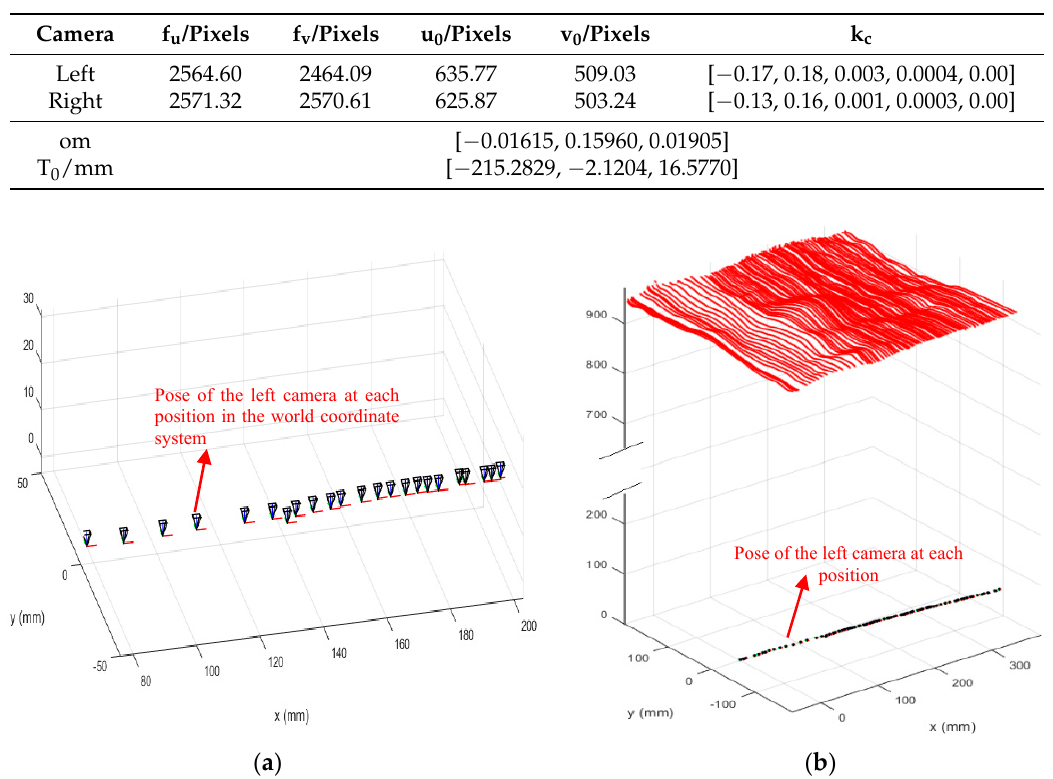
Figure 8. Splicing the light strips based on the camera pose information. Graph ( a ) shows the pose information of the left camera at the first 23 positions, and graph ( b ) shows positions of the restored light stripes and pose of the left camera in the world coordinate system. Sensors 2019 , 19 , 1583